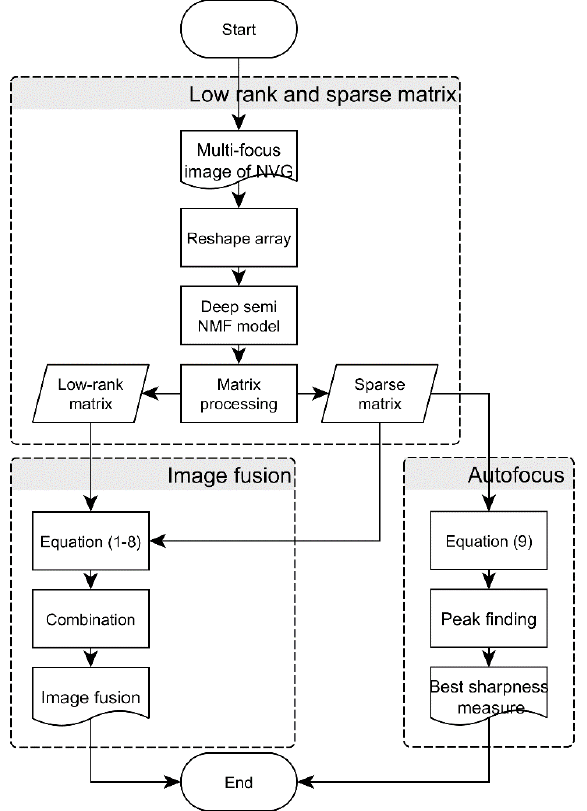
Figure 4. Autofocusing and fusion algorithm handling method.